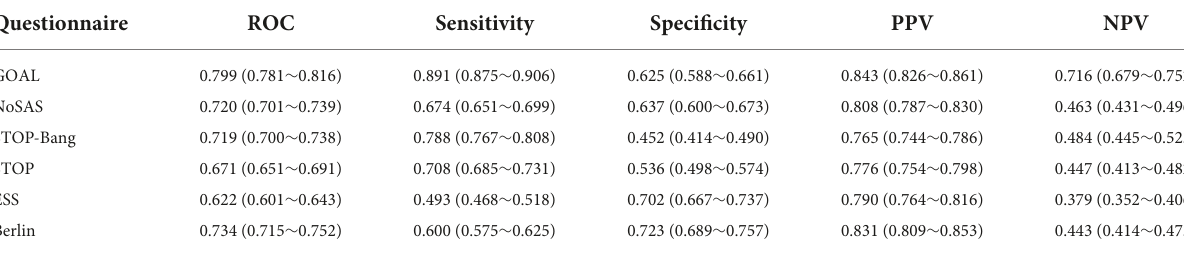
patients with suspected OSA. Among them, there were 458 patients (21.1%) with mild OSA, 349 (16.1%) with moderate